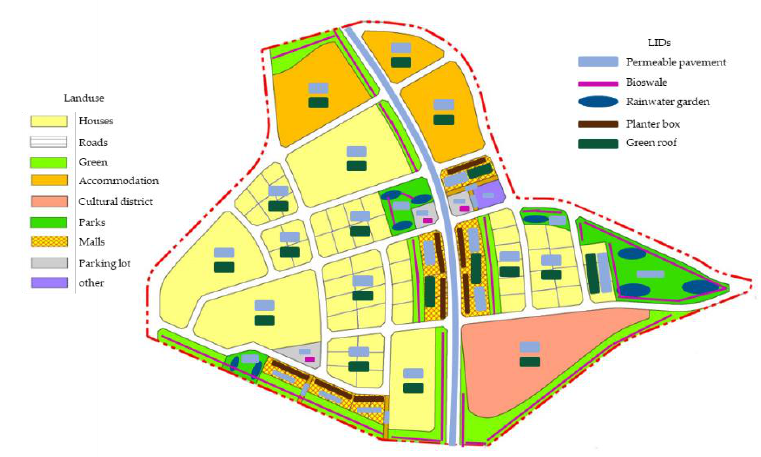
Figure 6. Overview of the deployment of LID techniques. Table 7. Parameter values of the LID